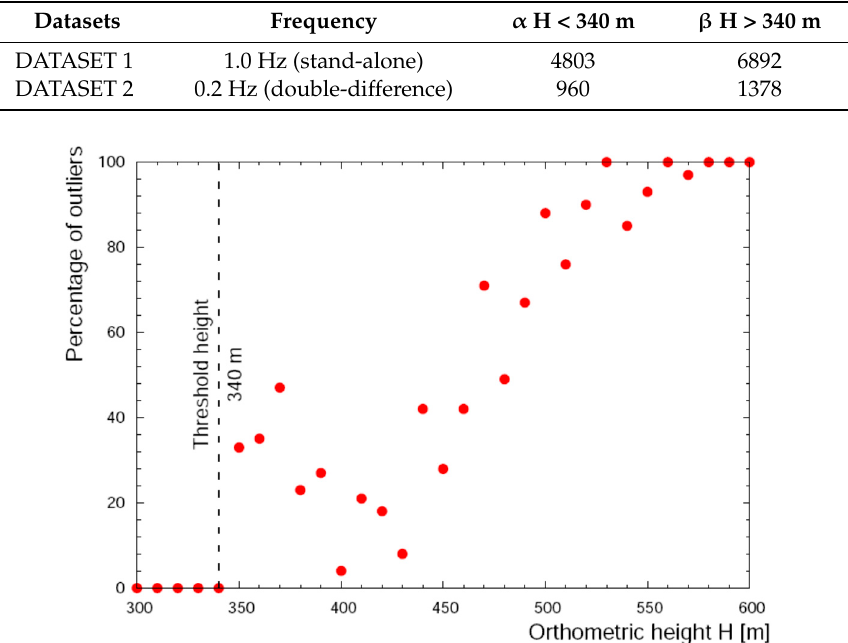
Table 2 . Number of entries of the datasets used in the analysis of the orthometric height values from GNSS, altimetric and barometric measurements. The 340 m height cutoff has been identified on the base of altimeter outlier data (see Figure 5), while the 0.2 Hz frequency is related to the availability of the Madonna Dell’Acqua master station data for the GNSS post-processing.